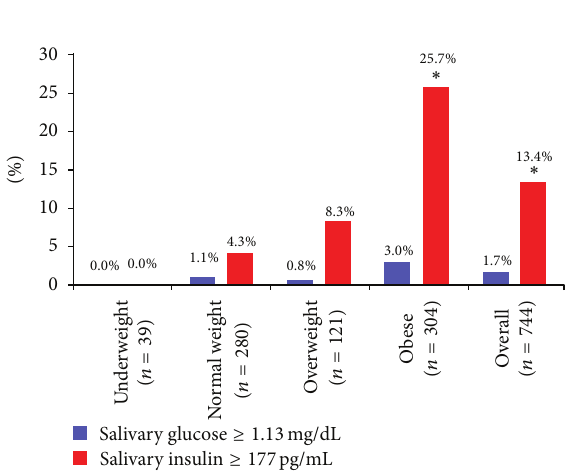
Figure 2: Percentage of the subset of 744 adolescents in each body weight category who had high salivary insulin and glucose concentrations. Only the values marked with an asterisk differed between high glucose and high insulin for each body weight